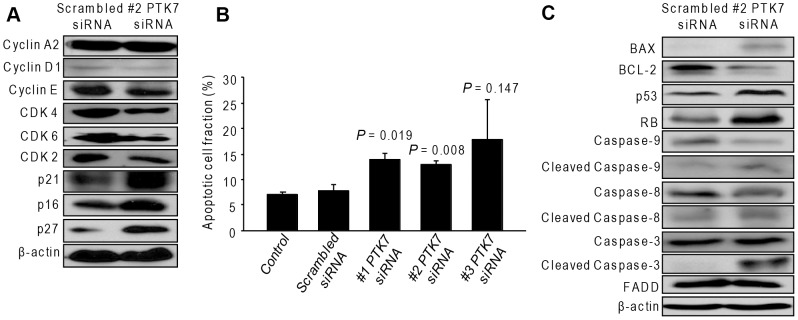
Effect of PTK7-specific siRNA on cell cycle and apoptosis in HuCCT1 cells.(A) Cell-cycle-related protein expressions with siRNA treatment. (B) The percentage of apoptotic cells with siRNA treatment. (C) Effect of siRNA on the apoptosis-related proteins. P values are presented for comparison with scrambled siRNA group. All experiments were replicated thrice with triplicate repeated measures within each replication for each time point. Data represent the mean ± SD.